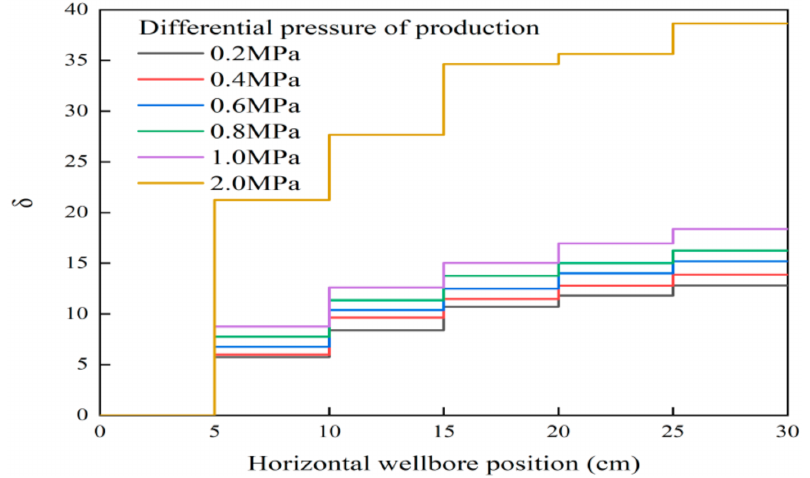
Figure 5. Distribution of δ along the horizontal well under different production pressures.